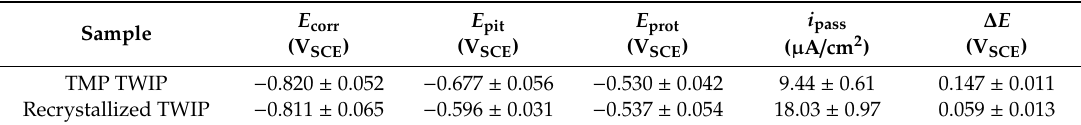
Table 1. Electrochemical parameters obtained from the CPP tests of TMP and recrystallized TWIP steels in deaerated 1.0 wt.% NaCl solution (see Figure 4).